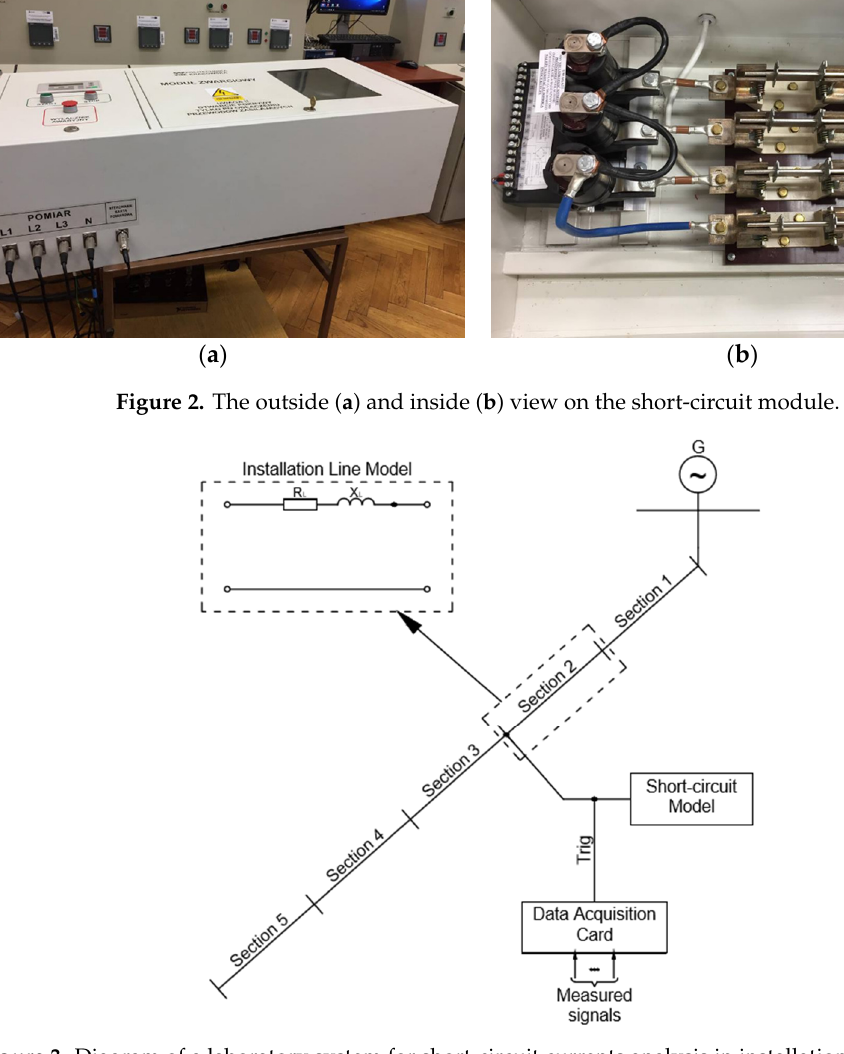
Figure 3. Diagram of a laboratory system for short-circuit currents analysis in installations powered by a synchronous generator.